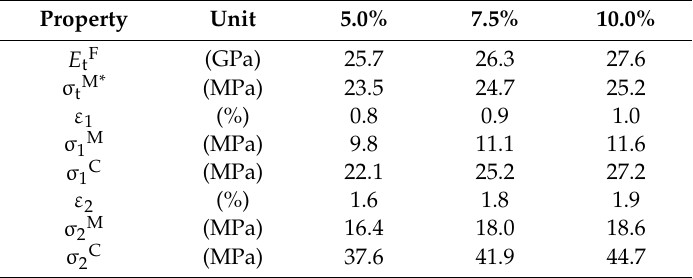
Table 4. Data used to solve the Kelly-Tyson modified equation with the method supplied by Bowyer and Bader.